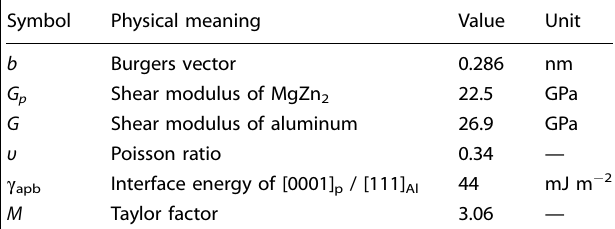
Table 3. Physical meaning and value of different symbols in the precipitation strengthening calculation 34,51,52